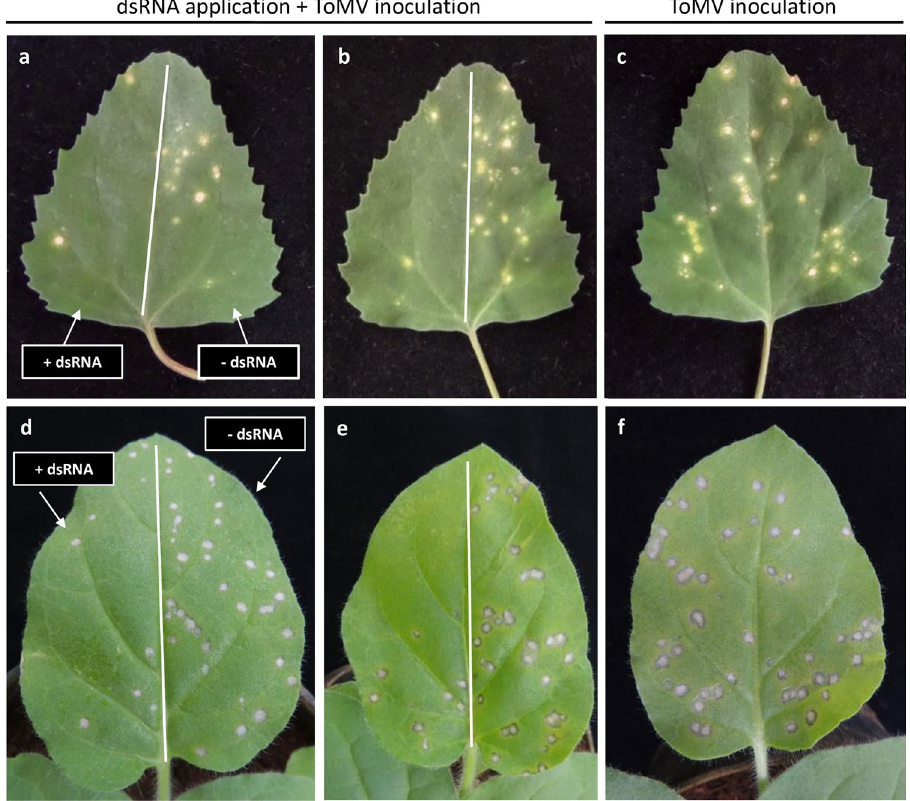
Figure 1. Chenopodium quinoa ( a – c ) and Nicotiana glutinosa ( d – f ) leaves with local lesions 4 days after mechanical inoculation of tomato mosaic virus (ToMV). dsRNA of ToMV- cp gene ( a , d ) and ToMV- mp gene ( b , e ) were mechanically applied on the left halves simultaneously with ToMV; the right halves were treated with DEPC-water and ToMV. As a control, only ToMV was inoculated on both halves of the leaves in ( c , f